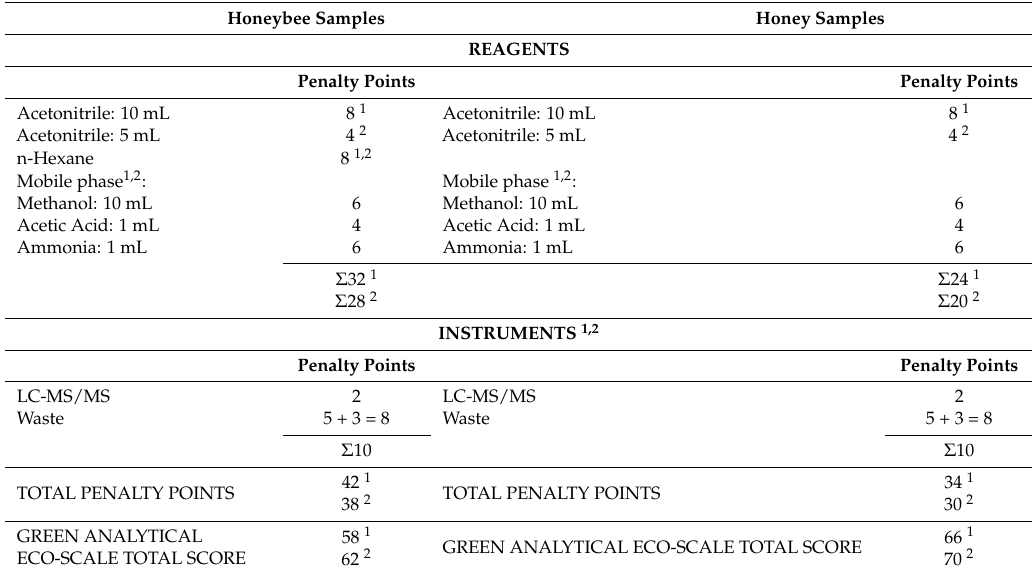
Table 3. The penalty points for pesticide residues determination in honey and honeybee samples using